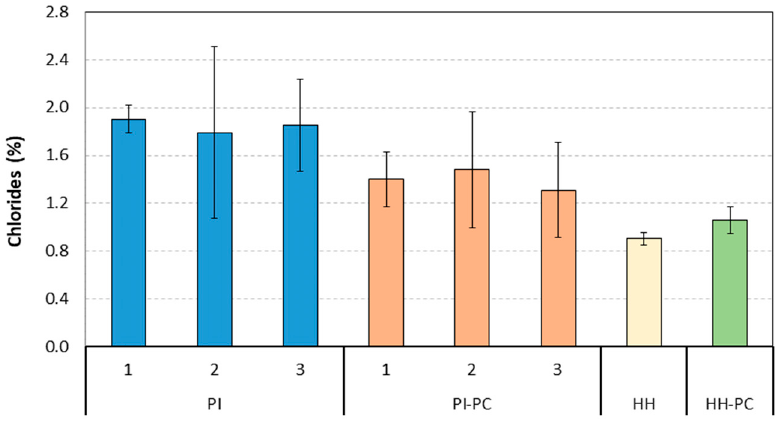
Figure 3. Chloride contents determined at the end of the 6-year exposure for reinforced mortar samples tested in different conditions. The numbers on the x -axis correspond to the regions marked in Figure 1.